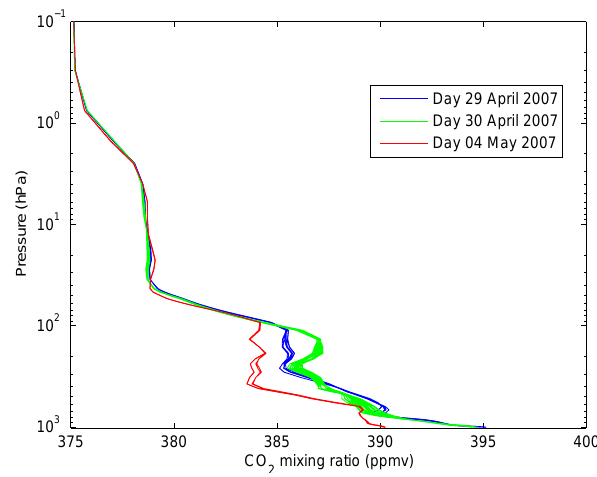
Fig. 5. JAIVEx case study, 29 April 2007. The figure shows the temperature profiles obtained from dropsonde data and the upper atmosphere ECMWF model data.